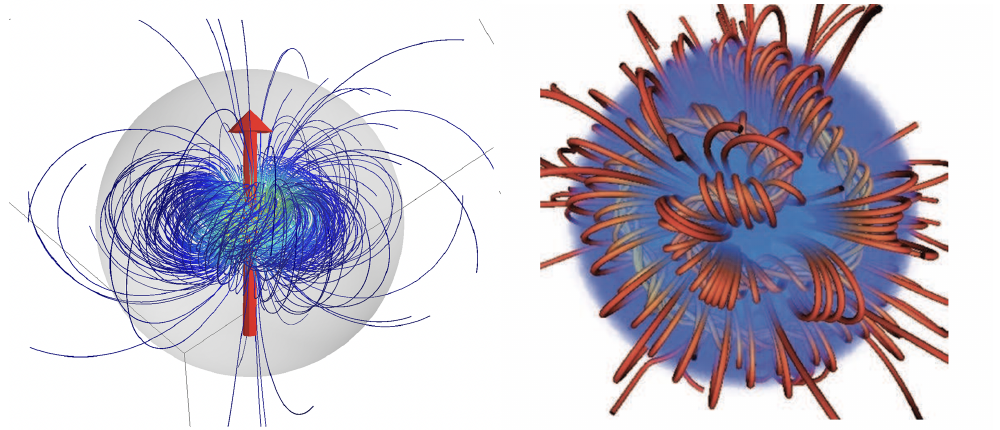
Figure 1. Examples of stable fossil field configurations. Left : Axisymmetric dipole field [117]. The fossil field is in stable equilibrium after more than 600 Alfvén times. Coloured lines represent magnetic field lines. The grey colour corresponds to the stellar photosphere, and the magnetic axis is shown with the red arrow. Right : Non-axisymmetric, complex magnetic structure in a stable configuration after several tens of Alfvén times [115]. The blue background represents the star as a spherical gas. Red lines indicate magnetic field